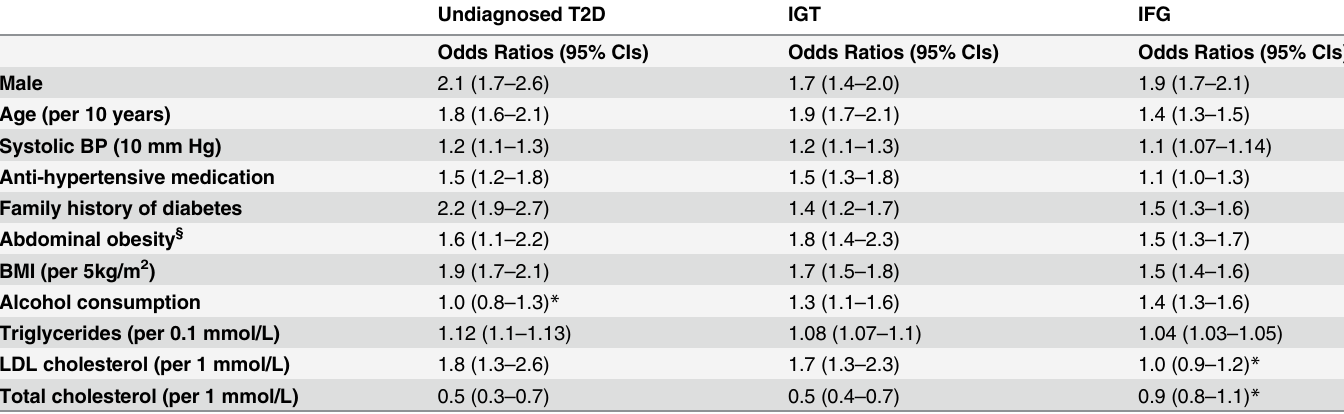
Table 3. Multivariable-adjusted odds ratios and 95% confidence intervals for having undiagnosed T2D, impaired glucose tolerance and impaired fasting glucose (compared with normoglycaemia) in the DMVhi study